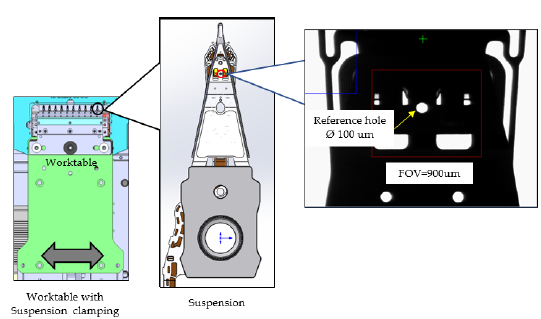
Figure 3. The worktable with suspension clamping